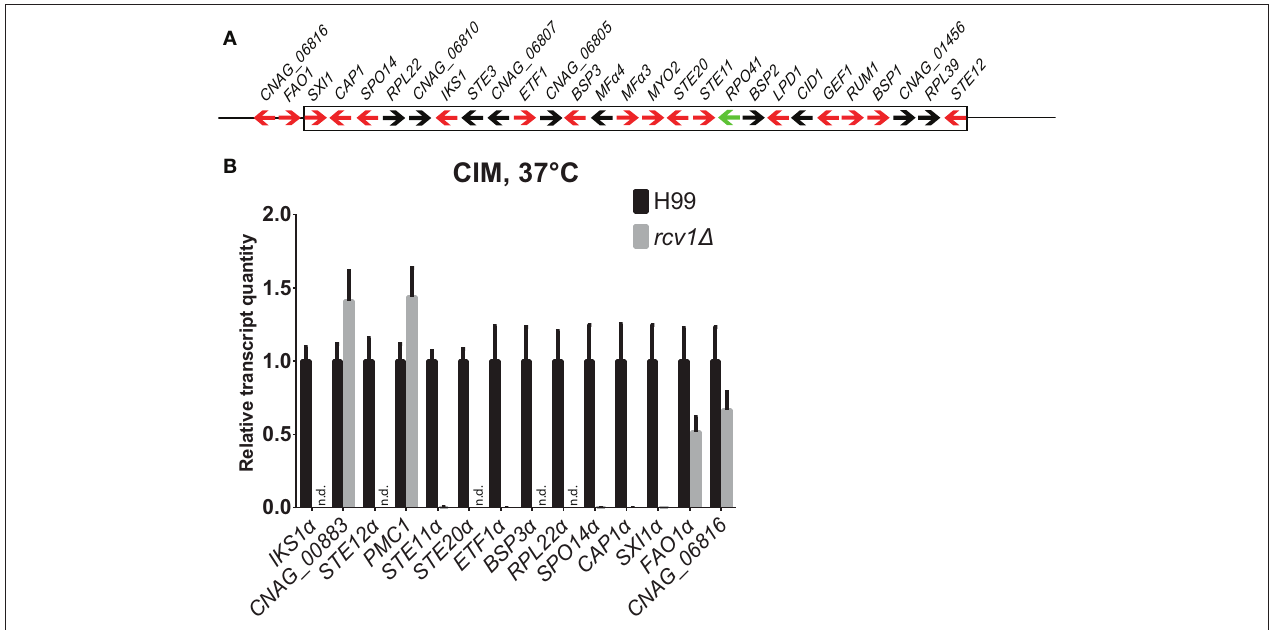
FIGURE 8 | The genes the expression whereof was most strongly affected by Rcv1 deletion are clustered in the MAT α locus. (A) Map of the MAT α locus of H99 (not to scale) based on the latest assembly by the Broad Institute. Arrows indicate annotated ORFs. Those in red are induced in the macrophage according to the work of Heitman and colleagues ( Fan et al., 2005) and repressed in the rcv1 ∆ strain in our RNA-Seq data. The only ORF for which data of the two studies are divergent, RPO41 α , is indicated as a green arrow. The box indicates the borders of the locus and two upstream ORFs that are also repressed in the rcv1 ∆ are also shown. See text for details. (B) Quantitative PCR validation of RNA-Seq data for a selection of RNA-Seq differential ORFs. The plots indicate relative transcript quantitation using ACT1 as the housekeeping transcript and H99, 4 h CIM at 37 ◦ C as reference. Bars are SDs. Samples were the same used for the RNA-Seq itself plus two independent RNA extractions for each condition. N.d., not detectable (transcripts were less than 0.01% of wild-type). The y axis is linear. See text for